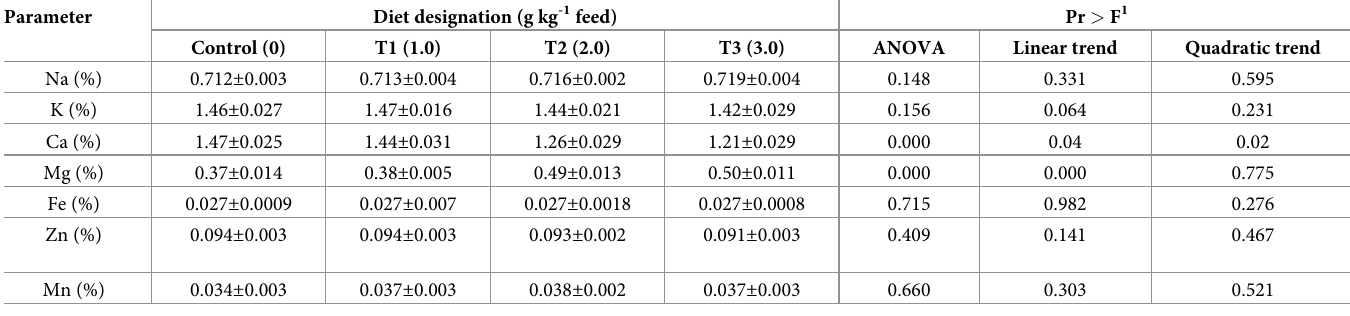
Table 5. Mineral composition of the muscle of B . gonionotus fed diets with graded levels of dietary chitosan after a 2-month feeding trial. Values are the mean ± SEM (N = 3).